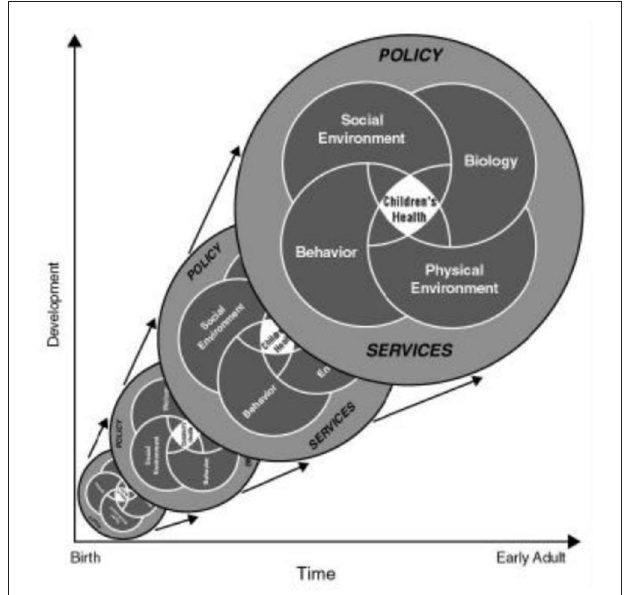
FIGURE 1 | Characterizing environment across the life course: an ecological approach (http://www.ncbi.nlm.nih.gov/books/NBK92206/). Policy and services affect the social environment, biology, behavior, and physical environment, which in turn affect children’s health. These factors change across time (x-axis) and development (y-axis), influencing children’s health along the